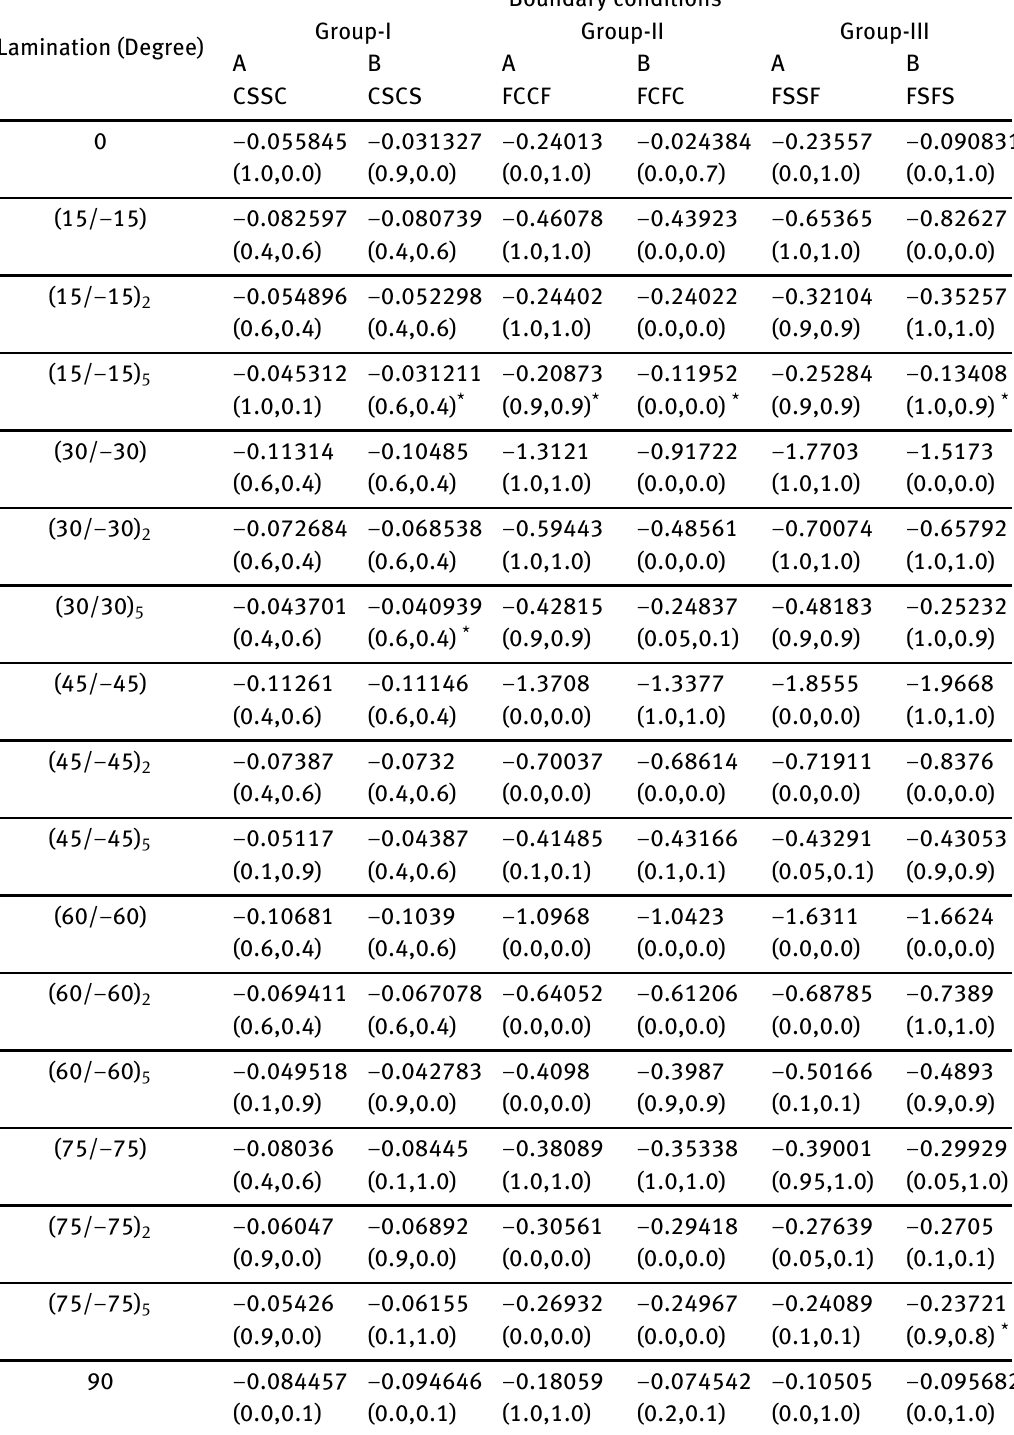
Table 15: Values of maximum non-dimensional clockwise twisting moments (− M xy ) x 10 2 for different antisymmetric angle ply lamination and boundary conditions of stiffened composite hypar shell with